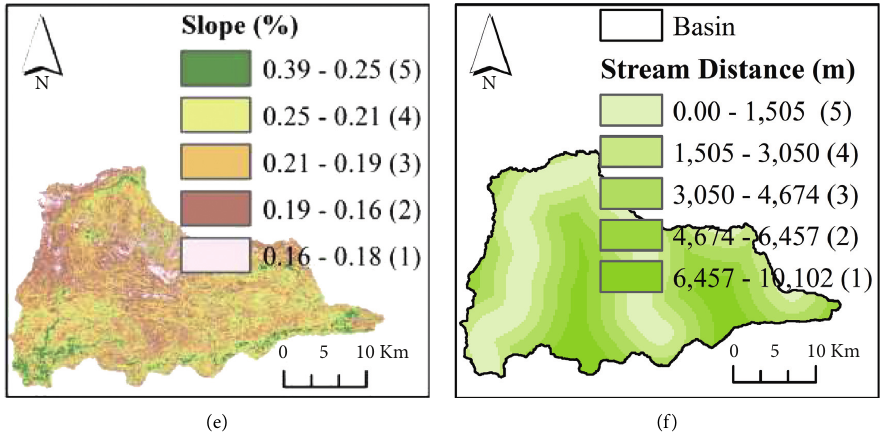
Figure 7: Reclassified flood causing factors based on flood vulnerability assessment: (a) R-factor, (b) NDVI, (c) SAVI, (d) population density, (e) slope, and (f) stream distance.